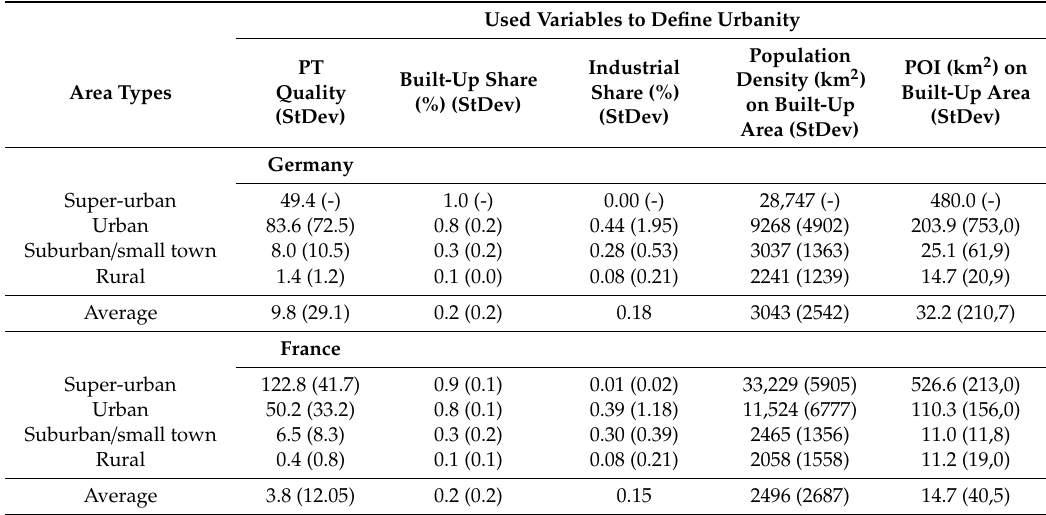
Table 3. Description of cluster-forming Variables of Germany and